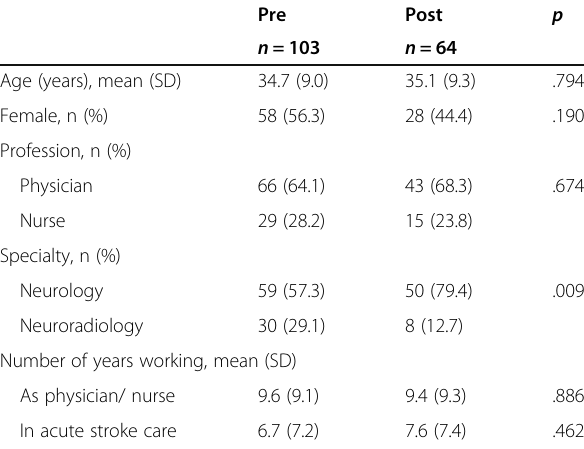
Table 2 Participant